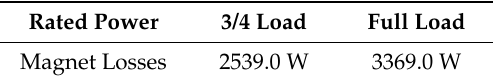
Figure 31. Magnet segmentation is required as soon as high magnetic flux fluctuations appear in the air-gap. A high level of segmentation must be in accordance with the manufacturing capabilities. When a high level in segmentation is used, a belt must cover the rotor to maintain the magnets place during the rotation. Table 13. Magnet losses.